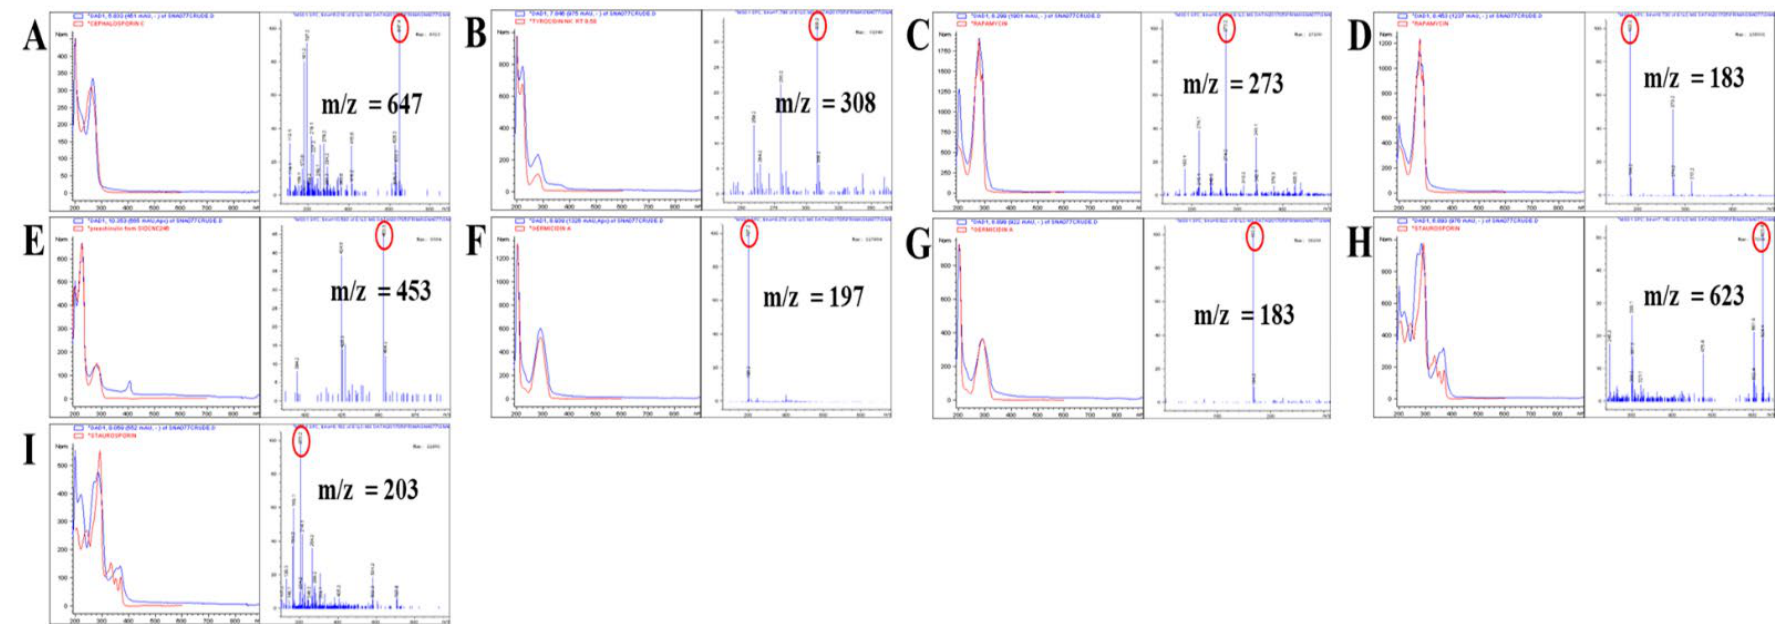
Figure 1. UV, ELSD, and mass spectra for compounds in culture extracts of SNA077 (blue) in comparison with known in-house compounds (red). ( A ) cephalosporin C, match score = 958; ( B ) tyrocidine, match score = 946; ( C , D ) Rapamycin, match score = 948, 961; ( E ) preechinulin, match score = 977; ( F , G ) germicidin A, match score = 971, 951; ( H , I ) staurosporin, match score 842, 870. Match scores higher than 900 were considered positive identification for that compound class.